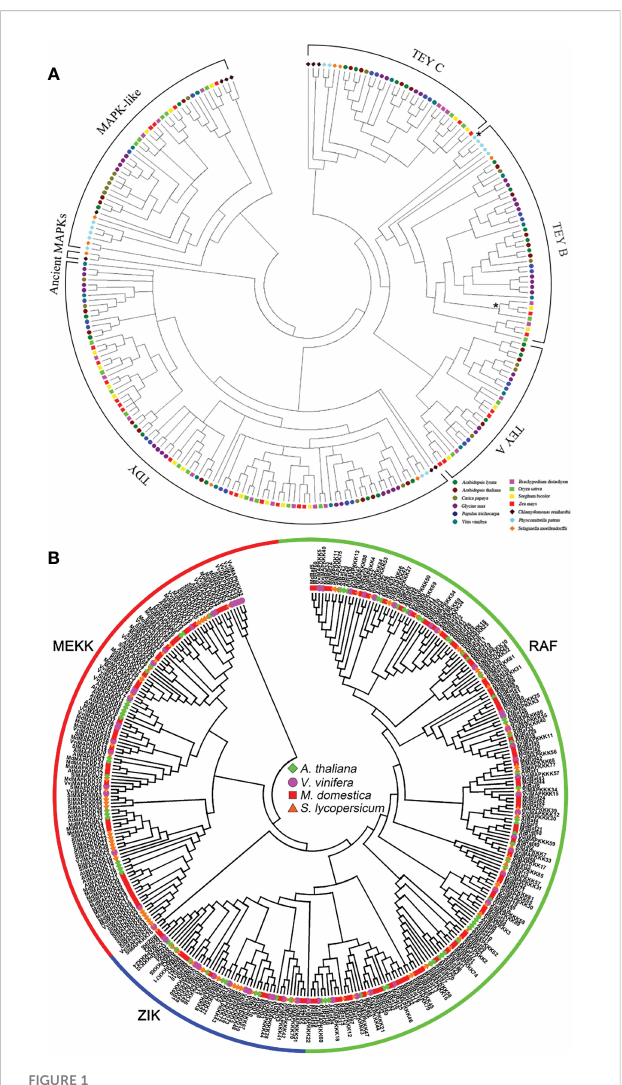
FIGURE 1 (A) Phylogenetic analysis of plant mitogen-activated protein kinases (MAPKs) and MAPK-likes in 13 plant species following Bayesian inference. Different colors indicate different species. The monocot clade and the PP sequence with the atypical MEY activation loop within the TEY-B clade are marked by asterisks. (B) Phylogenetic analysis of MAPKKKs in grapevine, apple, tomato, and Arabidopsis using the neighbor-joining (NJ) tree using MEGA-X with 1,000 bootstraps. Adapted from He et al. (2020) and Janitza et al. (2012), open-access articles distributed under the terms of the Creative Commons Attribution License (CC